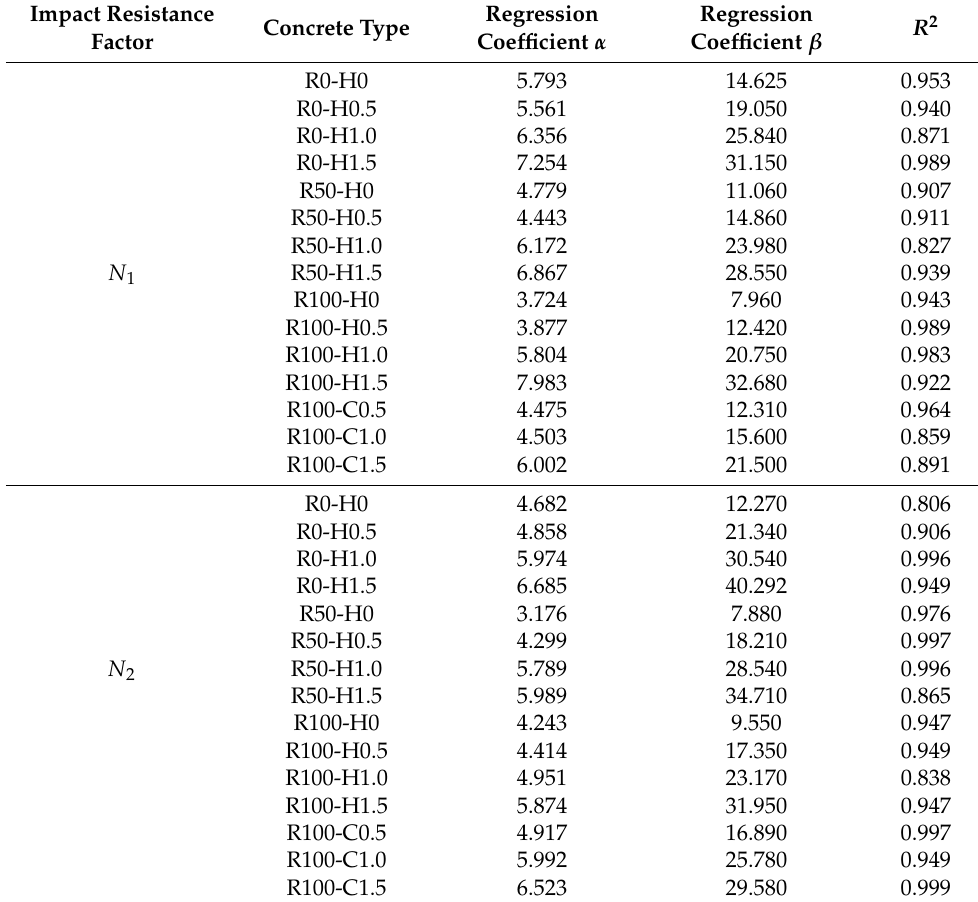
Table 8. Linear regression of resistance in Weibull